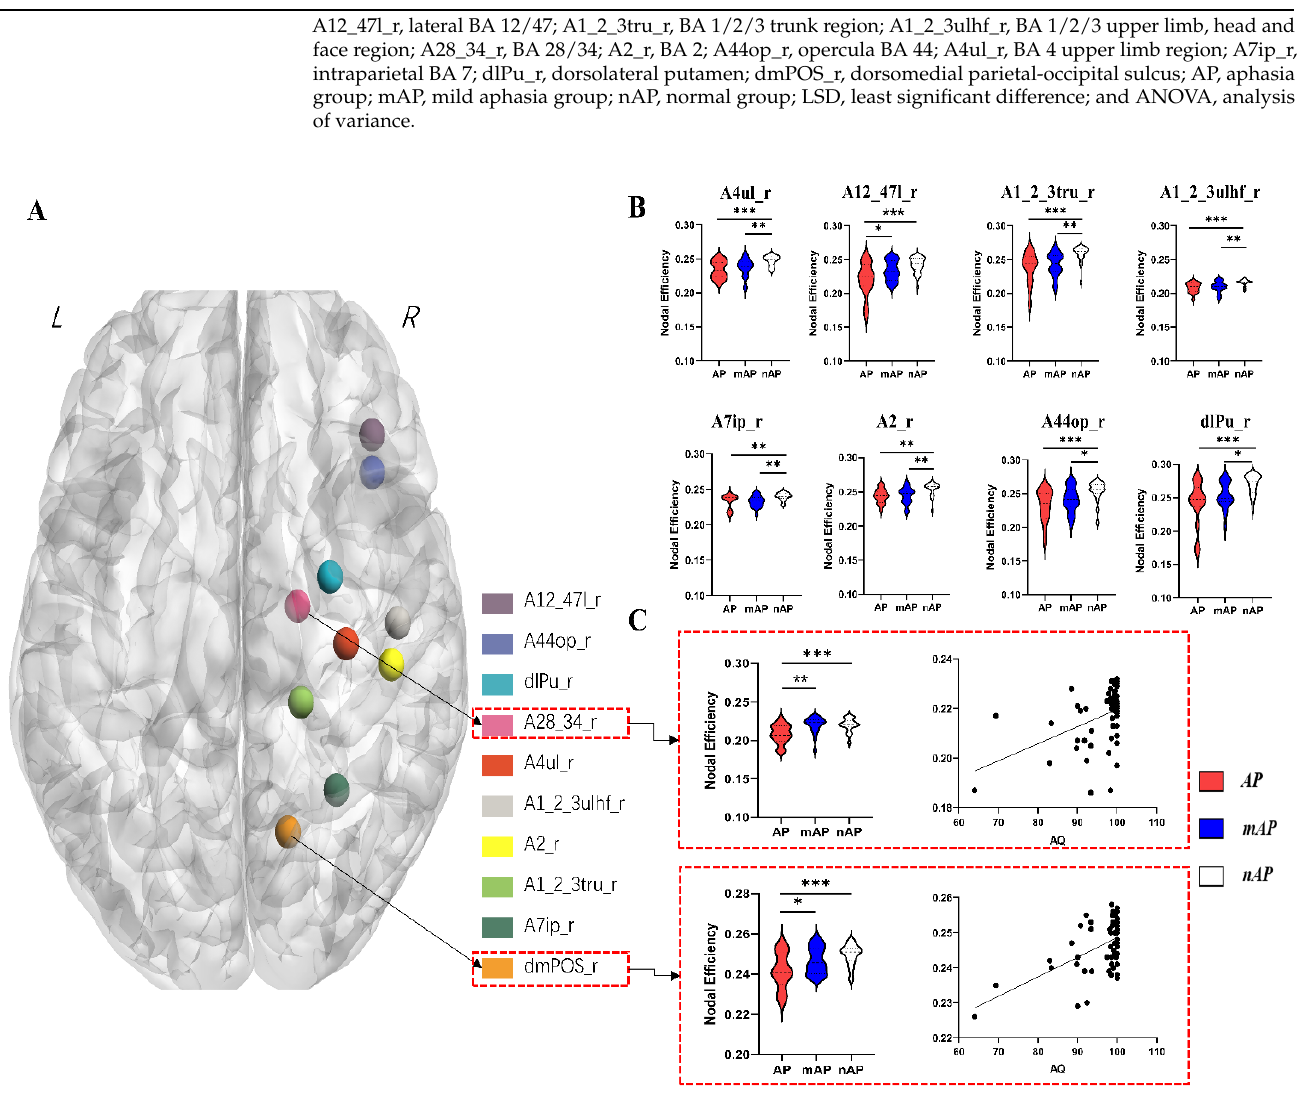
Figure 3. ( A ): A 3-D rendered figure showing all ten nodes with inter-group differences. ( B ): Violin